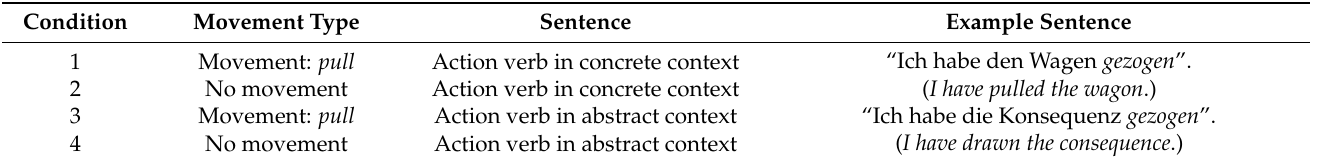
Table 1. Examples of the stimuli (from [18]) used for the four conditions in the current experiment.